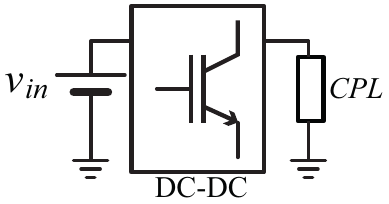
Figure 8. Scheme of dc–dc converter with